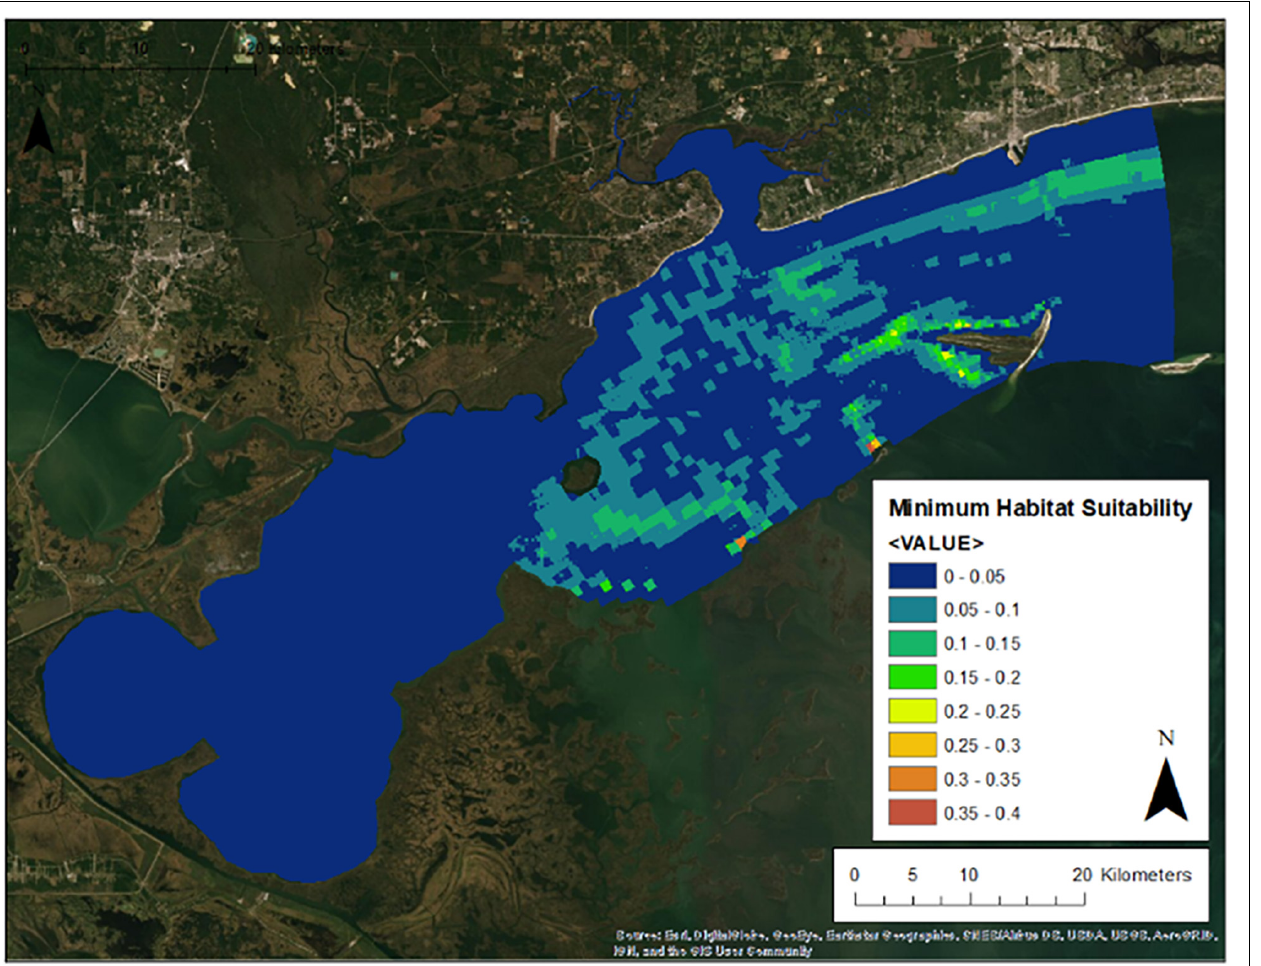
FIGURE 10 | Minimum habitat suitability between the 2009/2010 and 2016/2017 oyster years.